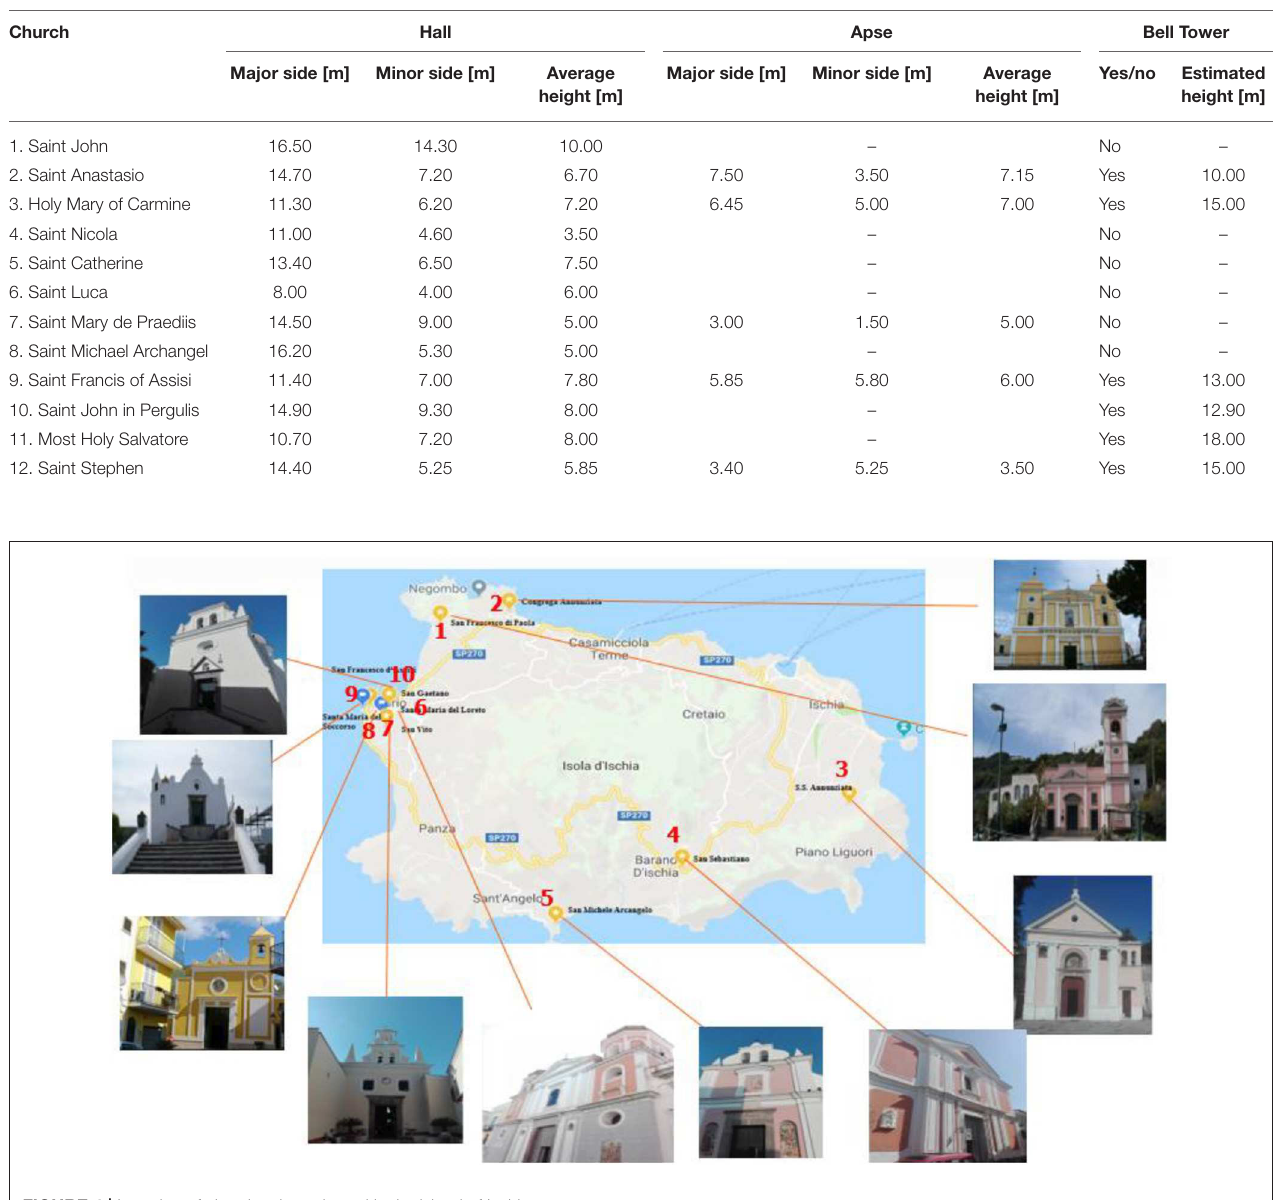
and foundation (no. 1), non-structural elements (no. 5), resistant system type and organization (no. 6), floors (no. 8), and fire vulnerability (no.